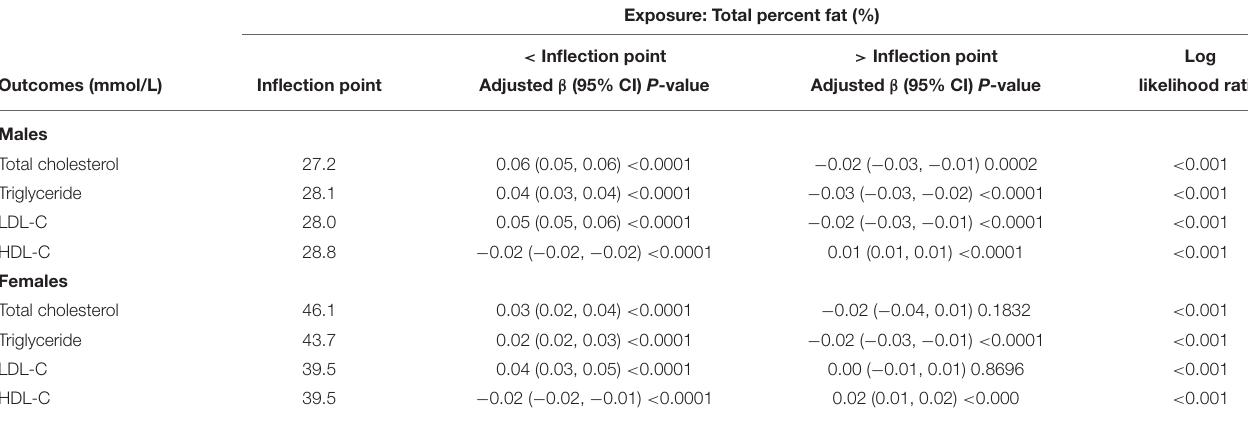
TABLE 3 | Threshold effect analysis of total percent fat (%) and lipid biomarkers (mmol/L) using the two-piecewise linear regression model. Exposure: Total percent fat (%) < Inflection point > Inflection